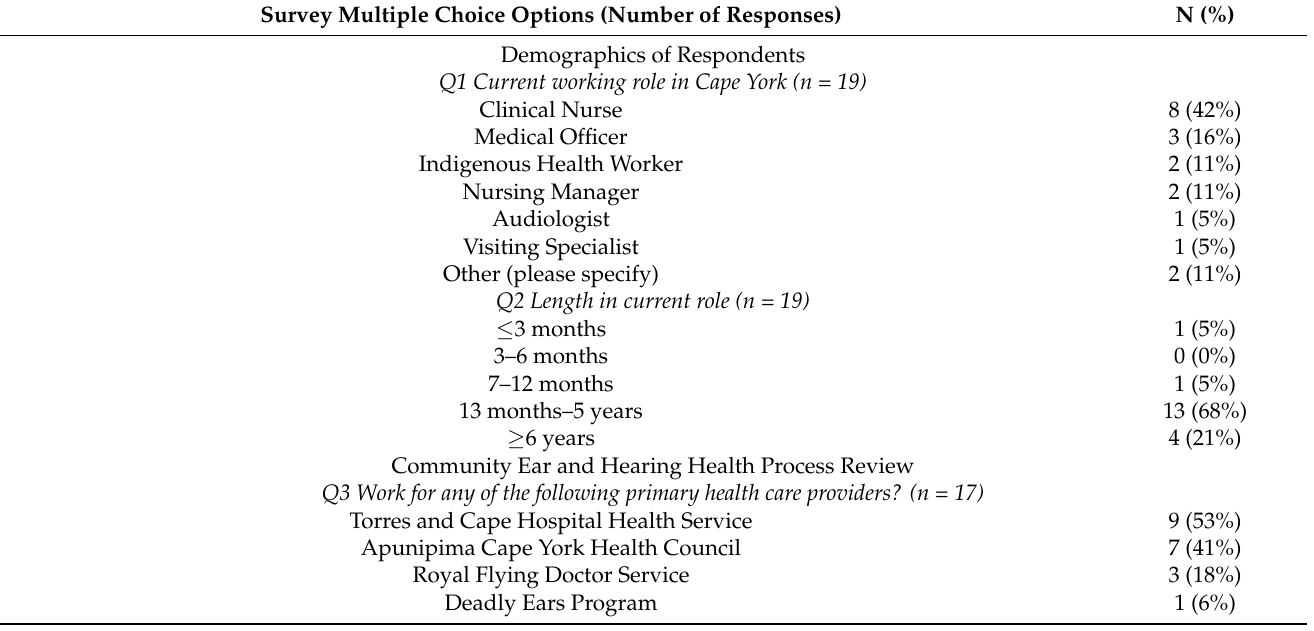
Table A1. Primary health care (PHC) clinician multiple choice survey responses. Survey Multiple Choice Options (Number of